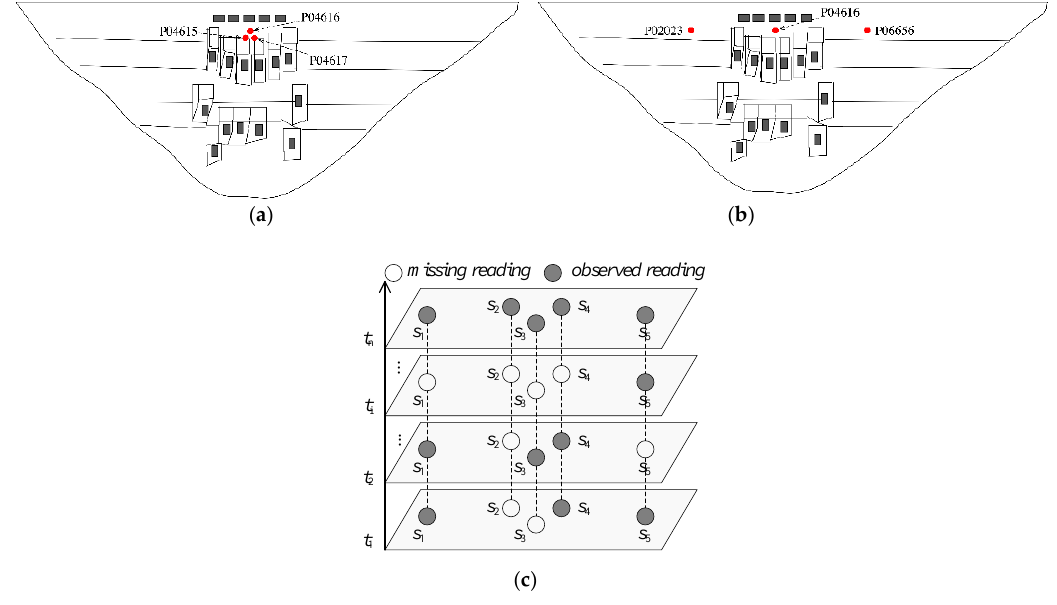
Figure 1. Illustration of sensor locations of dam deformation data. ( a ) Densely-deployed sensors; ( b ) loosely-deployed sensors; ( c ) missing readings situation.